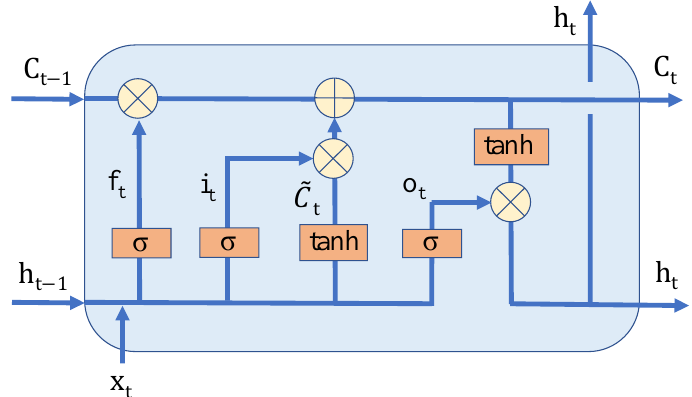
Figure 3. Graph of the LSTM cell [8].